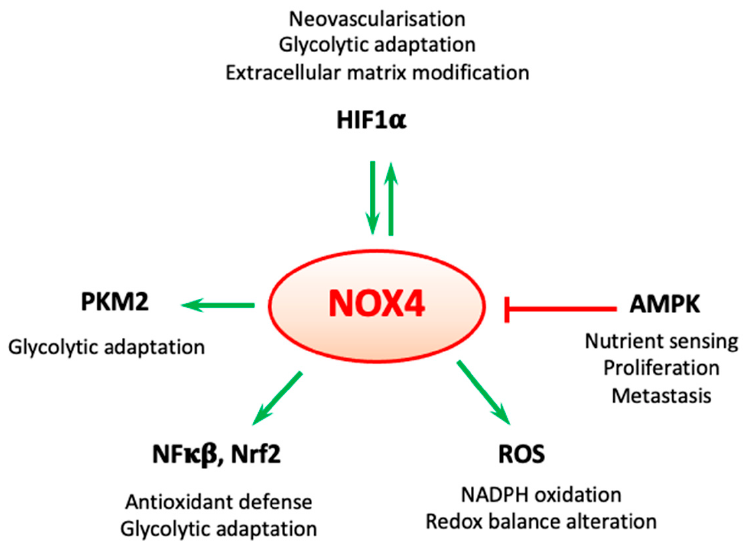
Figure 6. NOX4 in the center of carcinogenic metabolic rewiring. NOX4-mediated signals abet diverse signaling pathways to promote carcinogenesis. HIF1 α promotes NOX4 expression, and conversely, NOX4-mediated ROS is essential for HIF1 α -related glycolytic gene transcription and neovasculariza- tion through VEGF expression [142,158]. PKM2 requires NOX4 to achieve for glycolytic switch in cer- tain cancer types [92]. NOX4 aides the activation of the transcription factors NF κ B and Nrf2 [35,36]. NOX4-derived ROS directly modifies cellular redox balance and consumes the main antioxidant mol- ecule NADPH. AMPK links nutrient sensing to NOX4. Indeed, AMPK inhibits the hyperglycemia- related upregulation of NOX4 expression and hampers the NOX4-related upregulation of p53 and apoptosis in kidney podocytes [31]. Green arrows: enhancing effect, red line: inhibitory effect. 4. NOX4 As a Therapeutic Target in Cancers Unrestrained NOX4 activity has been described in diverse cancers, and NOX4 is now considered as a driving force in several cancer types [10]. In particular, upregulated NOX4 protein expression was identified by tissue microarray analysis in a series of malignancies including bladder, esophageal, head and neck, ovarian, and prostate carcinomas and ma- lignant melanoma [20]. Upregulated NOX4 expression mediated oncogenic proliferation in renal cell carcinoma, melanoma, glioblastoma, and in ovarian and pancreatic cancer [200–204]. In addition, increased NOX4 expression was related to poor prognosis in colo- rectal cancer and was put forward as a compelling pharmacologic target in digestive sys- tem malignancies [21,22]. Most interestingly, enhanced NOX4 expression was reported in thyroid cancers and in thyroid cancer cell lines. siRNA-mediated knockdown of NOX-4 abolished the upregulation of several metabolic enzymes involved in cancer cell adapta- tion [25,27,92]. Currently, the precise mechanism of NOX4-related oncogenesis in diverse